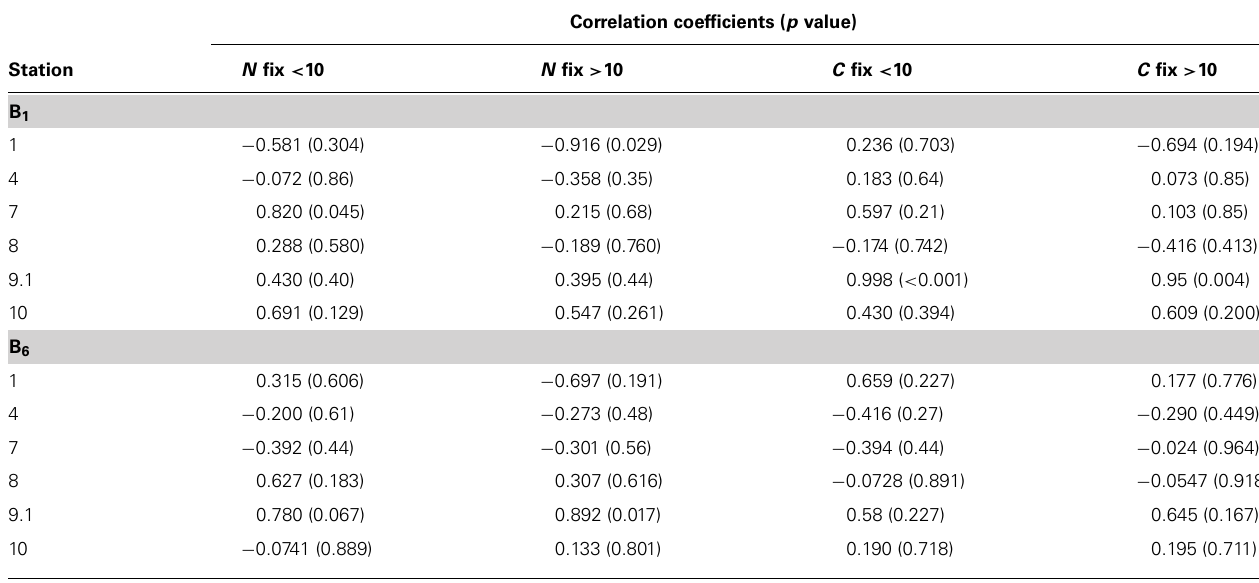
Table 2 | Correlation coefficients of vitamins B 1 and B 6 with nitrogen and carbon fixation in the less than and greater than 10- μ m size classes, direction of relationships, correlation coefficients, and p